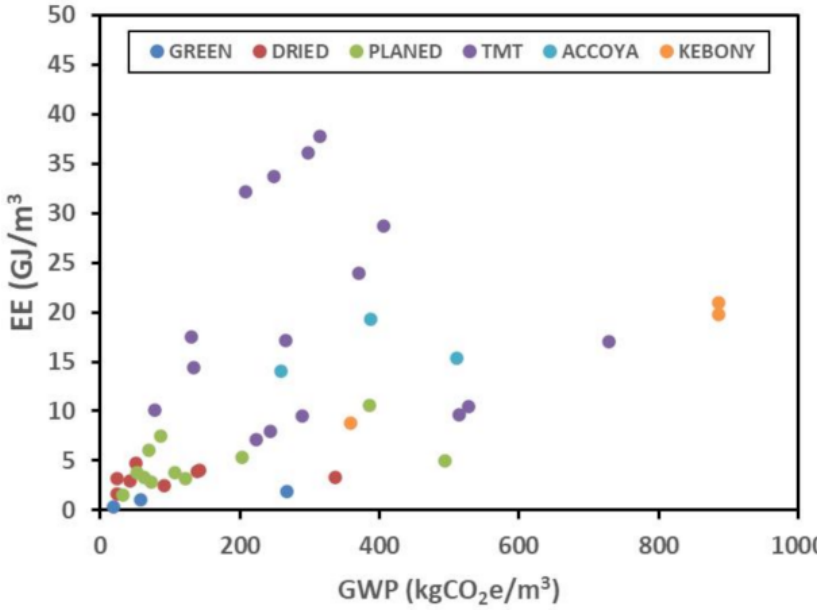
Figure 1. Relationship between embodied energy and global warming potential for unmodified and modified solid wood products, from published EPDs and literature.